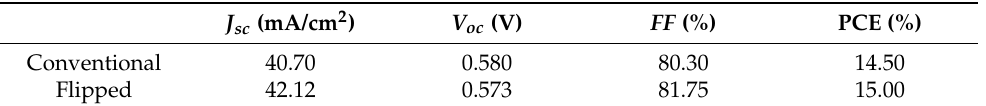
Figure 3. A comparison between the conventional npn and flipped structures: ( a ) external quantum efficiency (EQE) and ( b ) illuminated J–V characteristics. Table 1. Summary of the photovoltaic parameters for the conventional npn and the flipped mi-